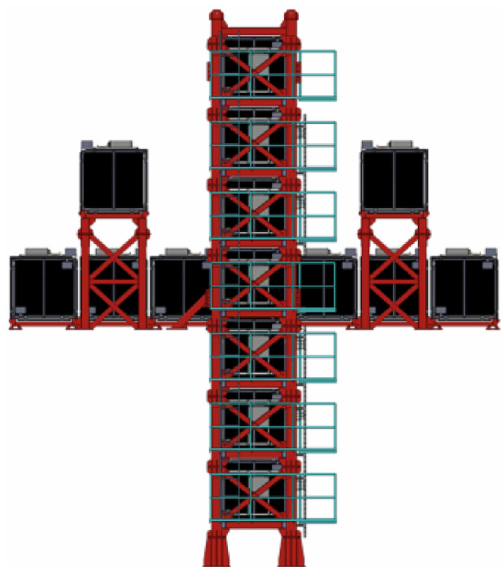
Fig. 48 An array of iron-scintillator sandwich detectors (INGRID) monitors the neutrino beam profile; a wide area to monitor mainly